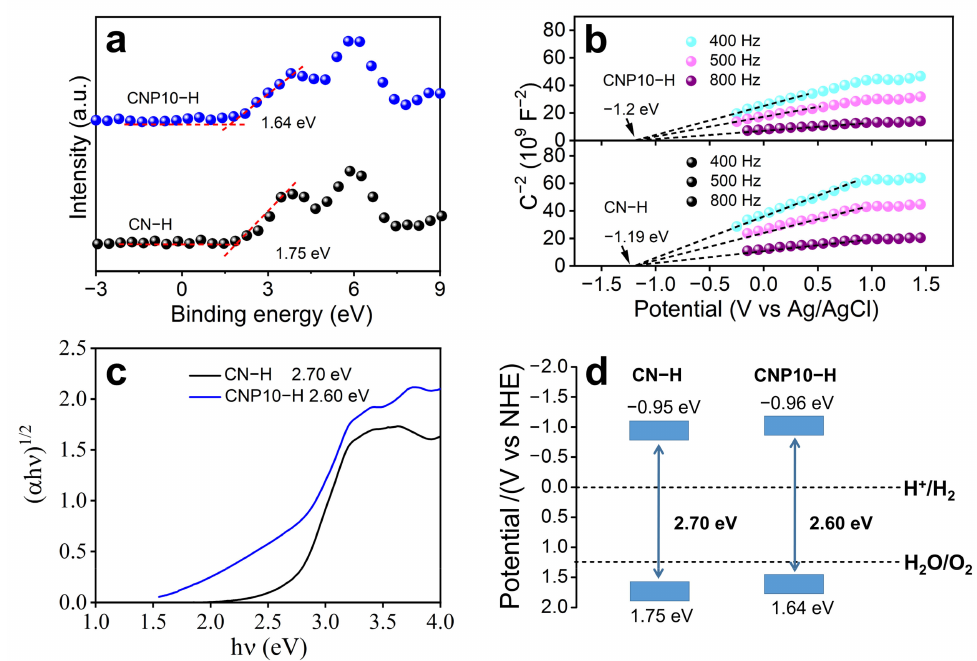
Figure 6. ( a ) VB XPS spectra of CN-H and CNP10-H; ( b ) Mott–Schottky plots of CN-H and CNP10-H; ( c ) band-gap energies of CN-H and CNP10-H; ( d ) band structure of CN-H and CNP10-H (1.75 eV and 1.64 eV are the valence band tops, and − 0.95 eV and − 0.96 eV are the conduction band